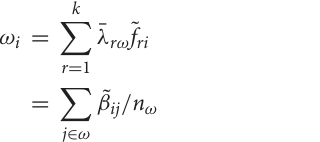
Non-genetic effects included random effects for blocks in the row and/or column dimension (Row and Column Block, respectively) and random Row and/or Column effects. Spatial models were all two-dimensional (column x row) with each dimension an autoregressive process of order one (ar1) or independence (id). Final column gives the number of